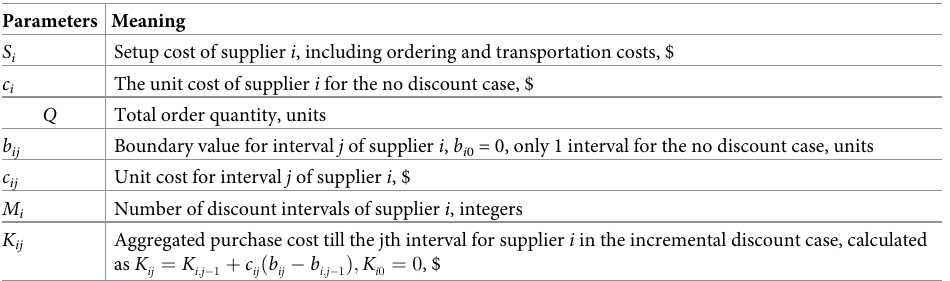
Fig 5. Carload discount (5 intervals). https://doi.org/10.1371/journal.pone.0283585.g005 Table 2. Parameters.